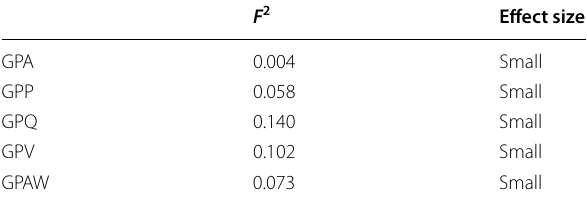
Table 5 F 2 (effect size) results